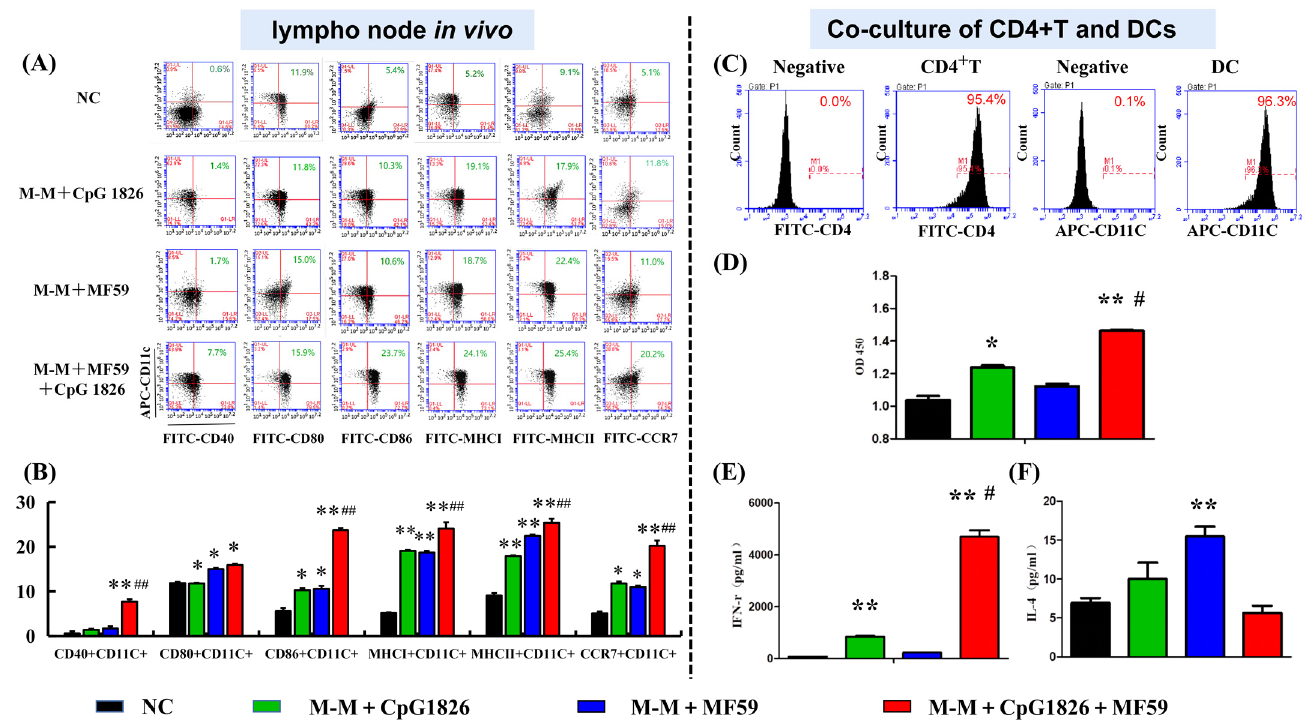
Figure 4. MF59 promotes CpG 1826- or M-M/CpG 1826-induced DC maturation, leading to Th1 activation. ( A ) The draining lymph node was isolated and s.c. injection of PBS, M-M/CpG 1826, M-M/MF59 and M-M/MF59/CpG 1826 in the flanks of C57BL/6 mice on day four with a two-week interval. The expression of maturation markers on LN DCs was analyzed by flow cytometry. ( B ) The percentage of DP cells is expressed as the mean ± standard deviation and is shown in a bar graph. ( C – E ) CD4+ T-cell activation is enhanced by coculture with BMDCs stimulated with the combination of MF59, M-M and CpG 1826. ( C ) The purity of CD4+ T cells from spleen samples from immunized mice and BMDCs from untreated mice was above 95%. ( D ) MF59/M-M/CpG 1826 synergistically increased the proliferation of cocultured CD4+ T cells and DCs. The production of IFN- γ ( E ) and IL-4 ( F ) in CD4+ T cells cocultured with DCs, as detected by ELISA. CD4 T cells were cocultured with DCs at a ratio of 50:1. All the experiments were repeated three times, and all the data are expressed as the mean ± SD ( n = 5). Data were derived from three independent experiments. * p < 0.05, ** p < 0.01 vs. NC group. # p < 0.05, ## p < 0.01 vs. the M-M/CpG 1826 group.